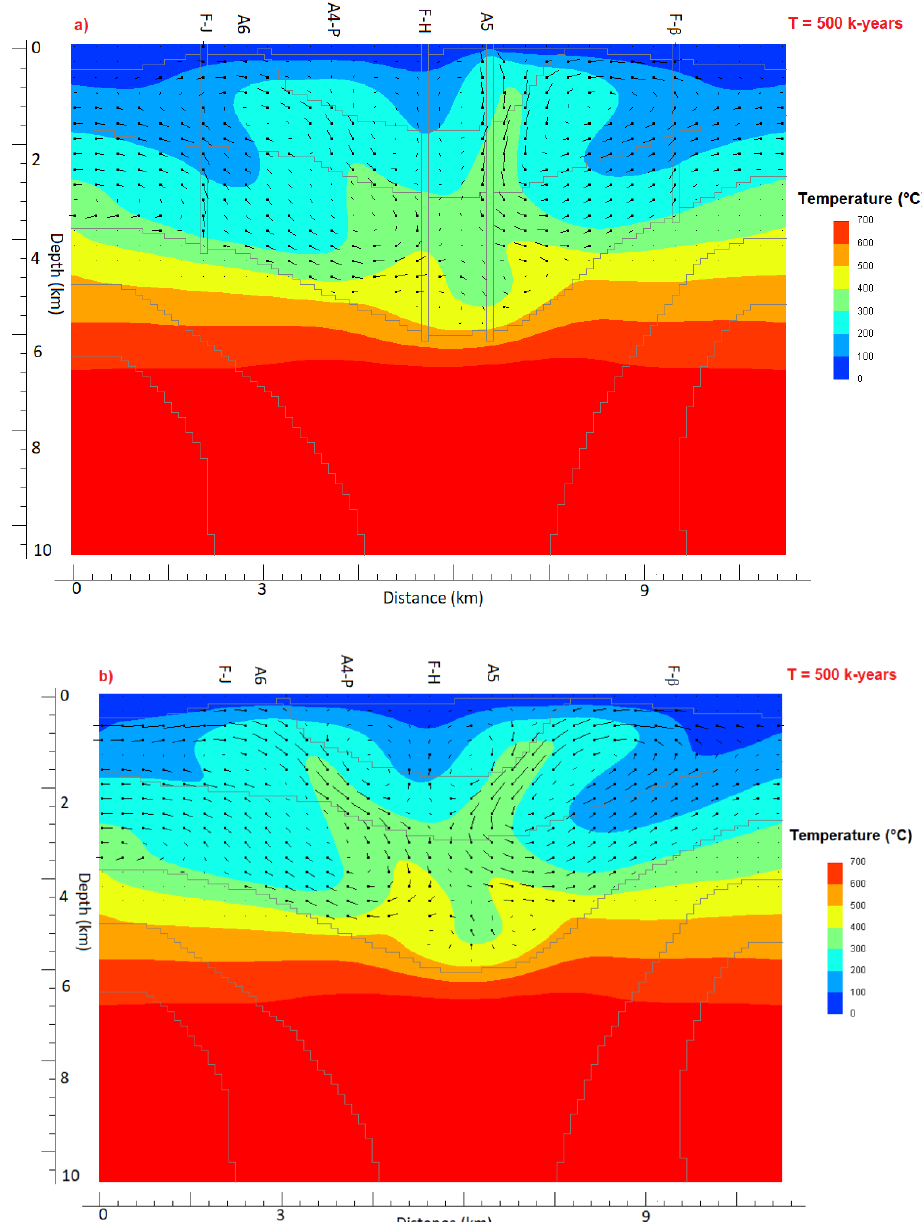
Figure 5. Simulated temperature and flow vectors at time 500,000 years for ( a ) scenario 5A and ( b ) scenario 6A. The direction of flow is from the point to the end of straight lines. The length of each line indicates the water vector magnitude, where 1.2 km = 10 −6 g s −1 cm −2 . Results obtained with scenario 5B show that both the deep and shallow hydrothermal circulations are directed toward the southwest rather than the northeast of the rift. Thus, one main hot upflow zone exists in the southwest of the rift whereas the northeast of the rift seems less hydrothermally active with potential cooling (Figure 6). Results obtained with scenario 6B are similar to those of 5B, but in the case of 6B, we observe a high magnitude of fluid vectors at the southwest edge of the rift, which can be considered a high discharge zone (Figure 6).